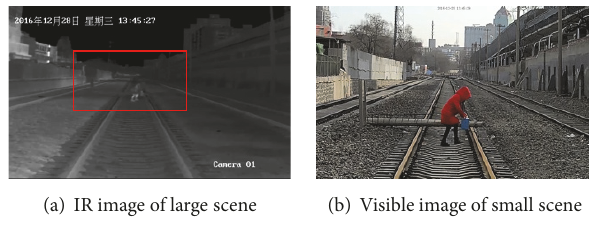
Figure 1: Railway IR and visible